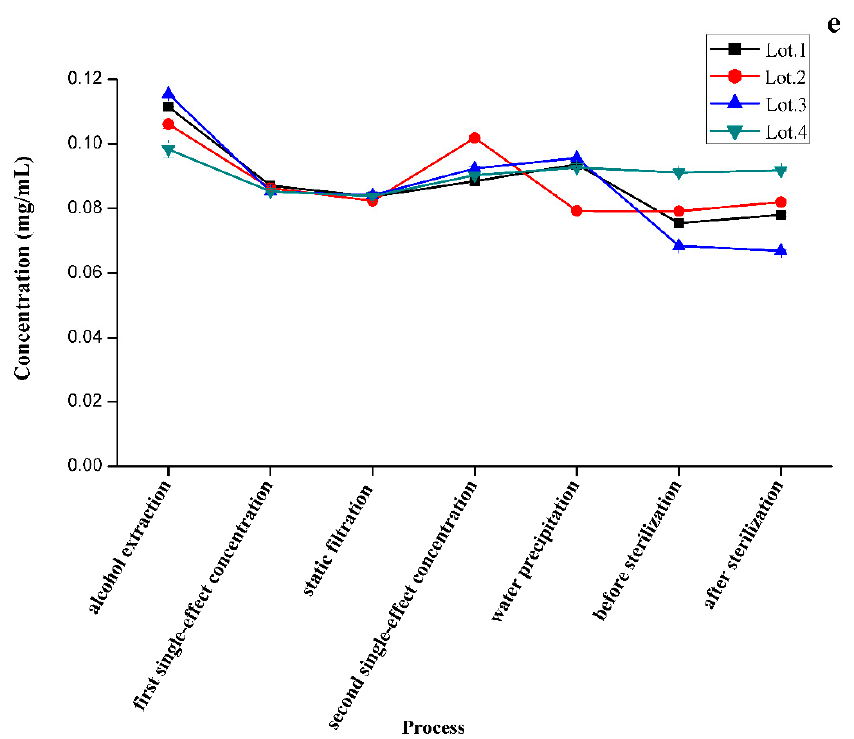
Figure 4. High-performance liquid chromatography photometric diode array (HPLC-PDA) chromatograms of ( a ) the sample solution of Panax ginseng extract intermediates including the processes of alcohol extraction (four times), first single-effect concentration, static filtration, second single-effect concentration, water precipitation, before sterilization, and after sterilization (1: Rg 1 , 2: Re, 3: Rb 1 , 4: Rd); the transfer process of ( b ) Rg 1 , ( c ) Re ( d ) Rb 1 , ( e ) Rd.